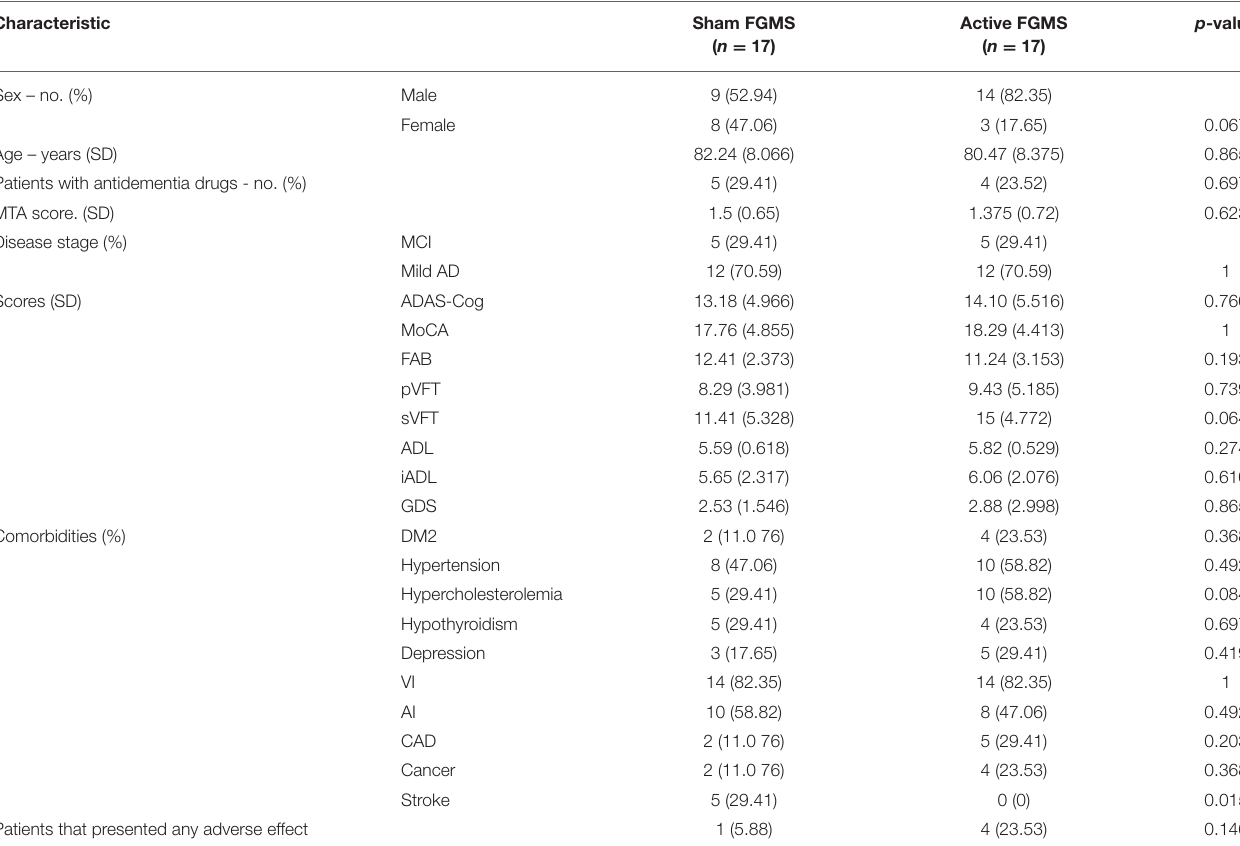
TABLE 1 | Baseline characteristics and evaluations of participants in both the sham FGMS and active FGMS groups. Characteristic Sham FGMS